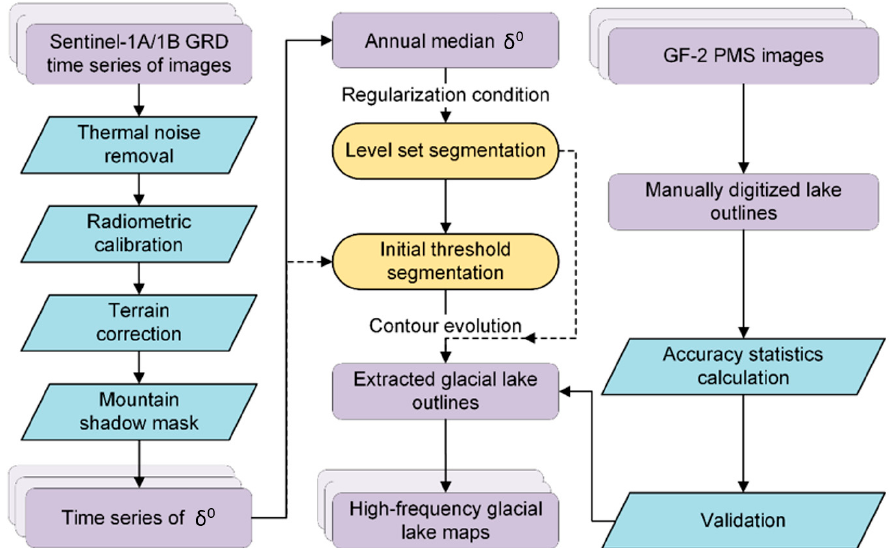
Figure 2. Flowchart of our method for mapping the glacial lakes at a high temporal resolution based on the time series of Sentinel-1A/1B SAR data.